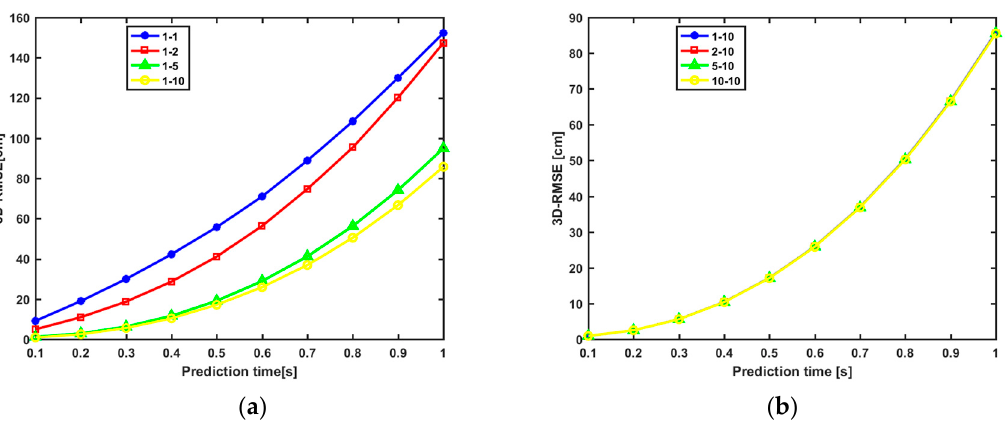
Figure 15. The effects of the broadcast and sampling rates in test 1. ( a ) Fixed SRGM; ( b ) fixed BRPM. Table 1. RMSE of predictions of position increments.